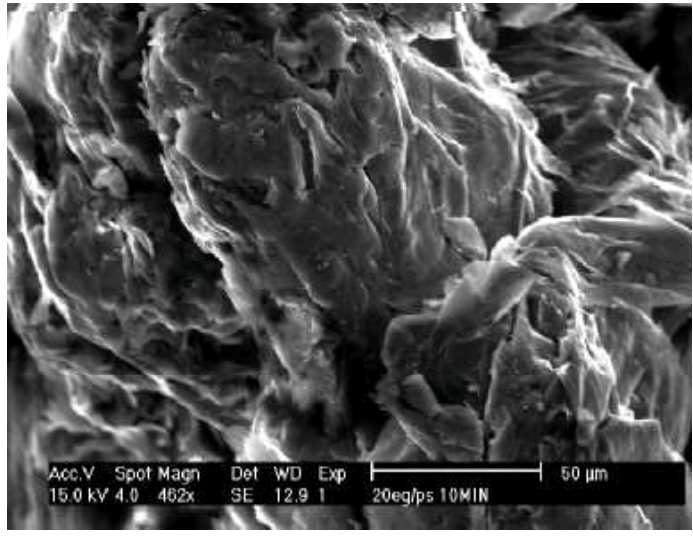
Figure 1. SEM image of the cross-section of the EG-PS film.